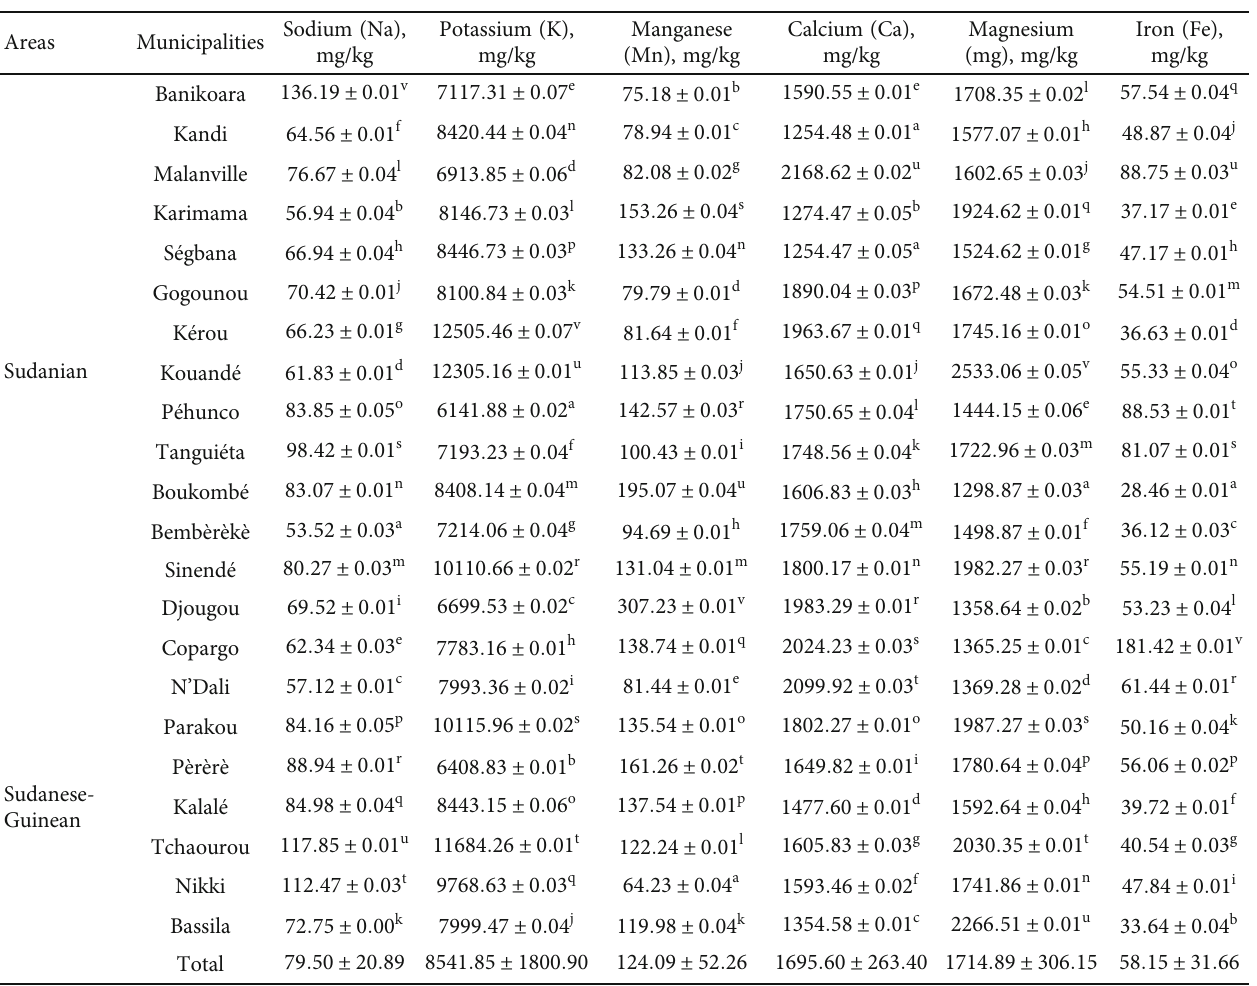
Table 3: Contents of some mineral elements in Detarium microcarpum